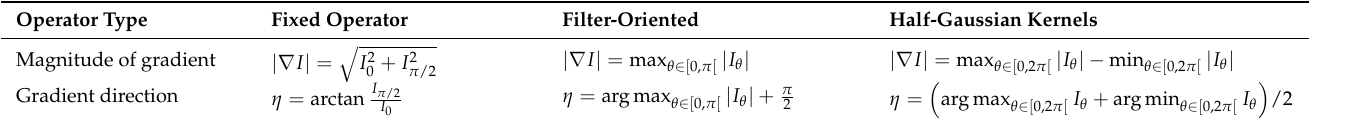
Figure 1. Schema of the gradient-based methods. Table 1. The gradient magnitude and orientation calculation for a scalar image I , where I θ represents the derivative of the image using the first-order filter in orientation θ in radians